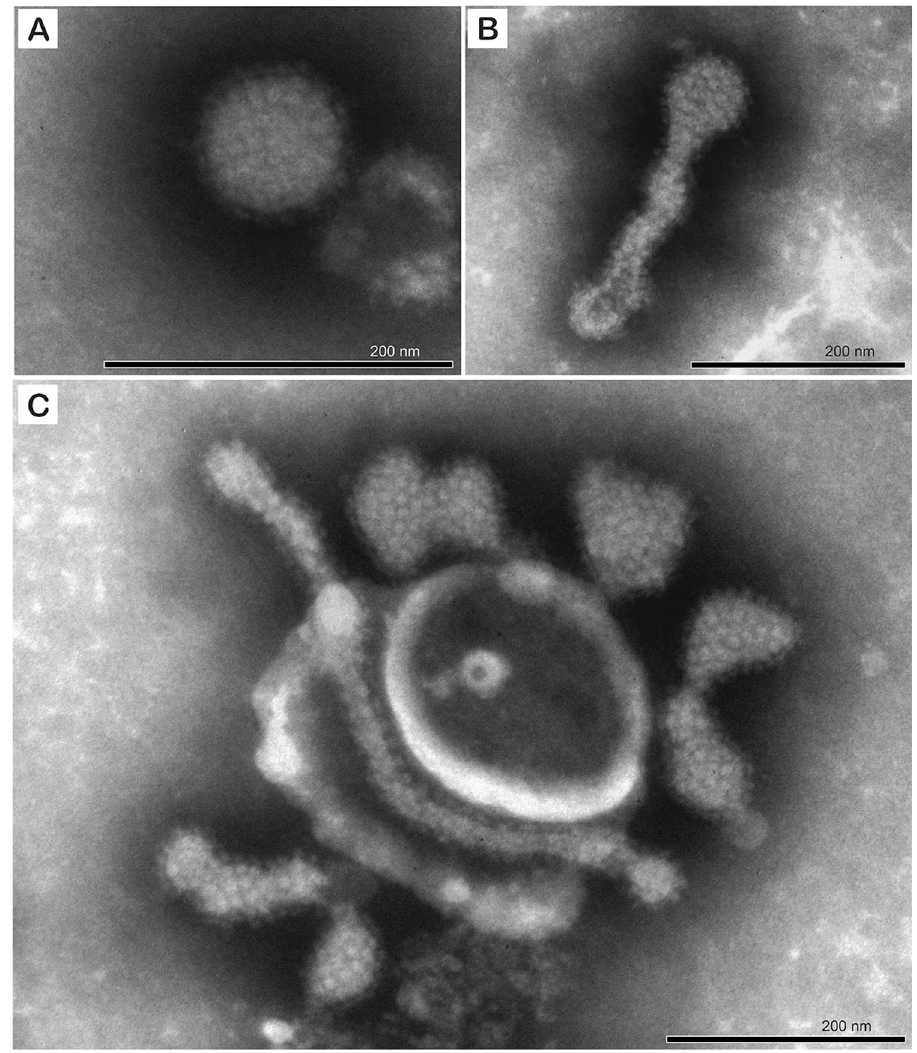
Fig 7. Negative stain electron photomicrograph illustrating the ultrastructural features of the Turtle fraservirus 1 (TFV1) virion. A) spherical particle with prominent glycoprotein spikes. B and C) pleomorphic particles including elongated forms. Scale bars = 200